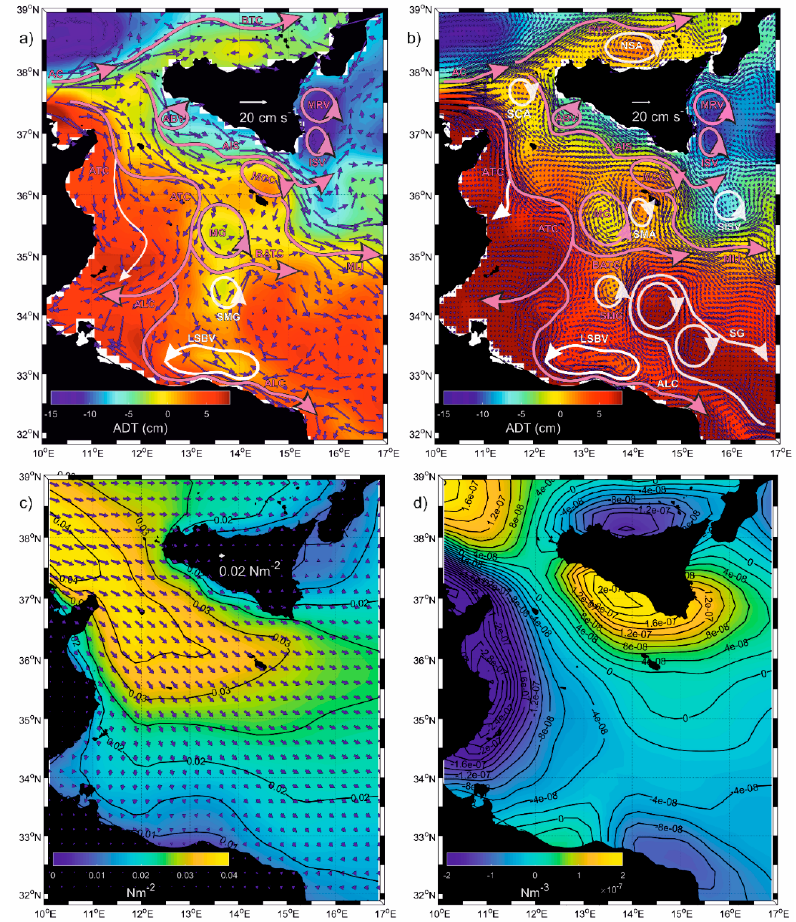
Figure 2. Mean drifter currents ( a ) in spatial bins of 0.25° × 0.25° (blue vectors) superimposed on mean maps of absolute dynamic topography (colors) during the period from 1993 to 2018. Mean optimal currents ( b ) in spatial bins of 1/12° (vectors; one vector every two grid points is plotted) superimposed on mean maps of absolute dynamic topography (colors) during the period from 2012 to 2016. The structures emphasized with white arrows in panels ( a , b ) are new or with different shapes and positions with respect to those described in Figure 1b. The structures already known are highlighted with pink arrows. ( c ) Mean map of the wind stress amplitude (colors) and direction (vectors) and ( d ) wind stress curl over the period from 1993 to 2016.